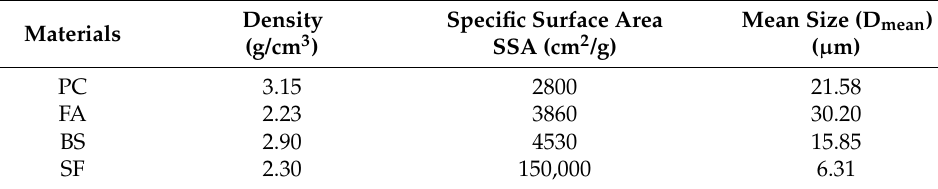
Table 1. Physical properties of cementitious materials.